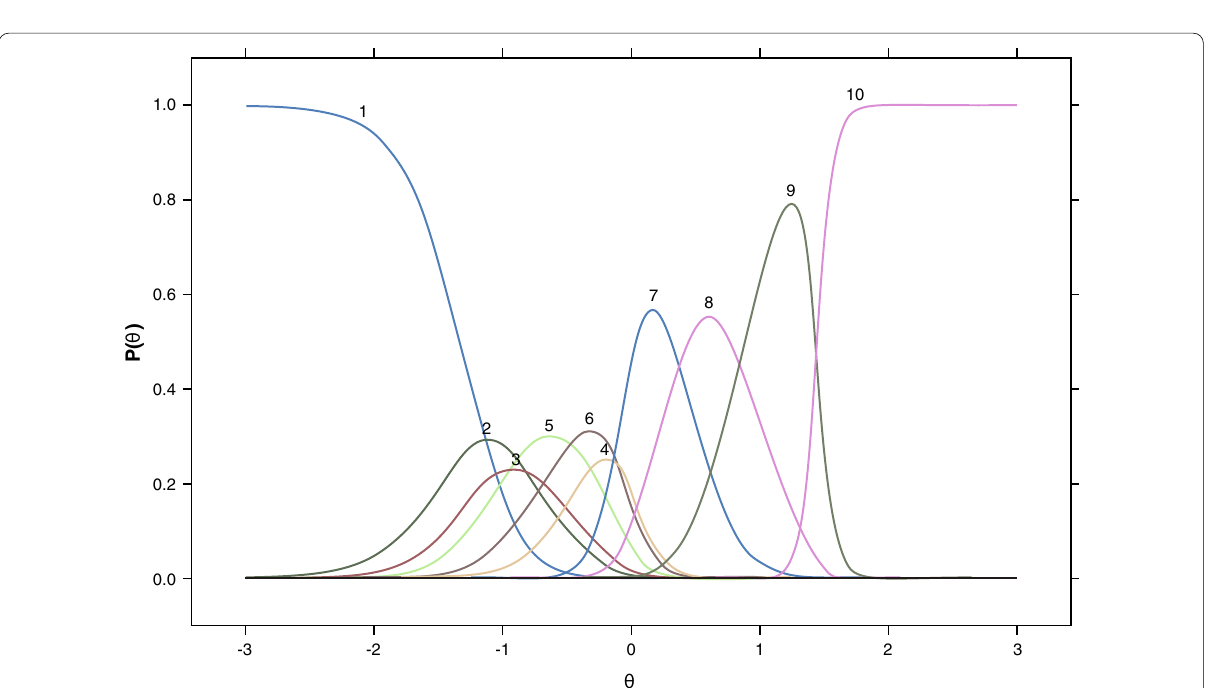
Fig. 1 Nominal item characteristic curves for the Performance Hour 1 and correspond to the testlet responses as defined in Table